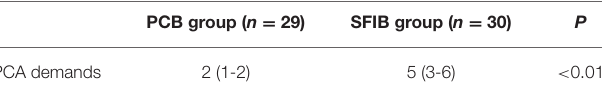
TABLE 5 | PCA demands within the first 24 hours after